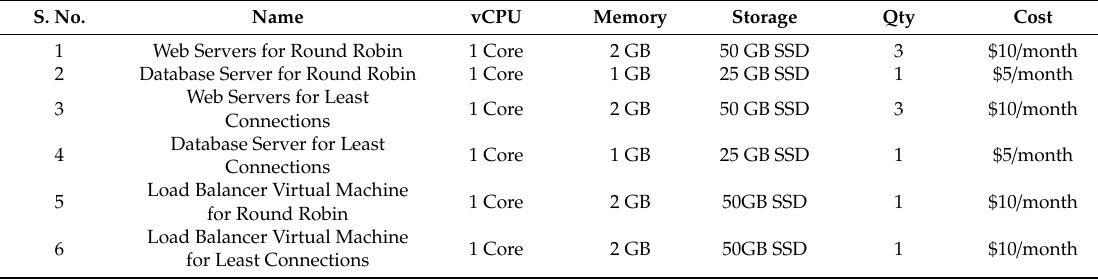
Configuration of virtual machines used in cloud architecture for analysis of load balancer